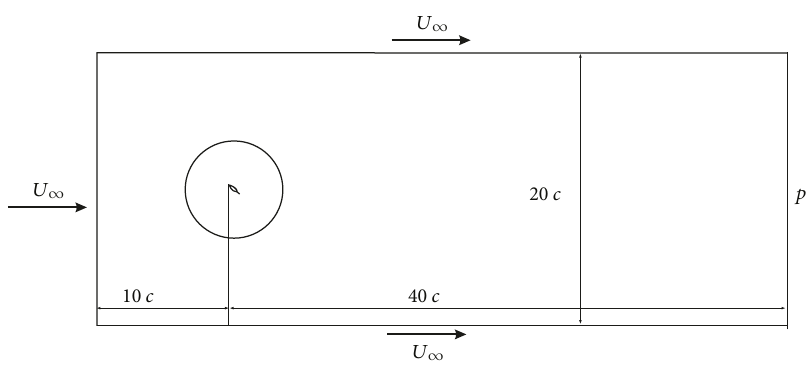
Figure 2: Flow fi eld domain: dimensions and boundary conditions.